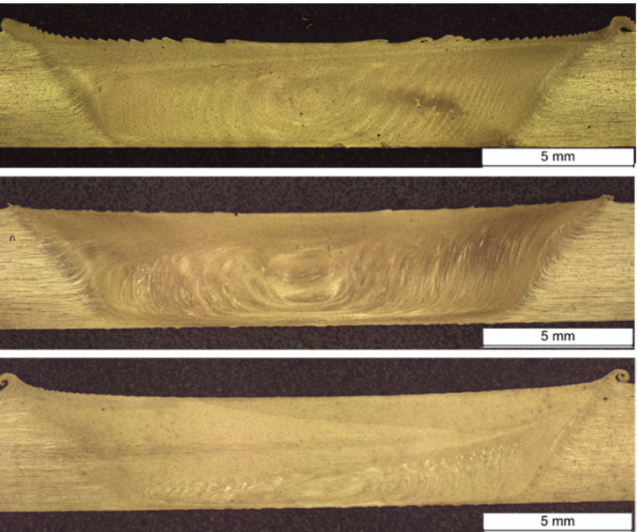
Figure 23. Cross sections tools 2-20-8 ( top ), 3-20-8 ( centre ), and 4-20-8 ( bottom ) with 0.9 mm gap; n = 300, f = 100.